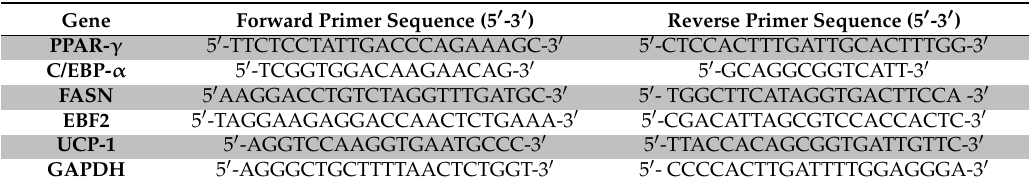
Table 1. qPCR primer sequences of target